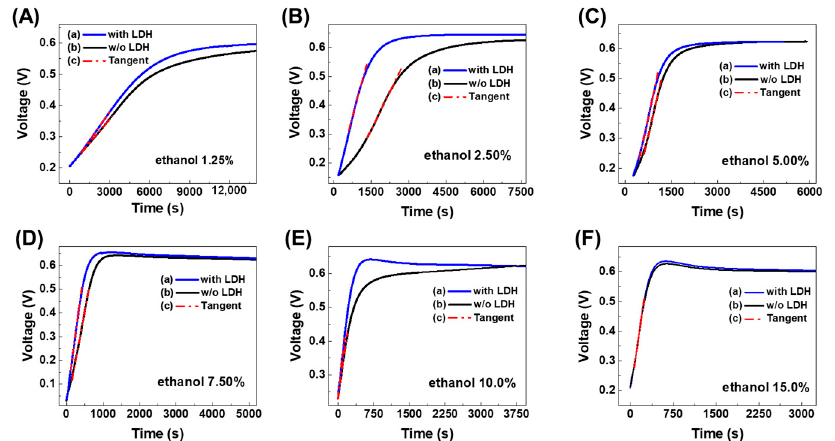
Figure 2. Open-circuit fuel cell voltage charge curves as voltage vs. time, performed by operating with different percentages of hydroalcoholic solution: ( A ) 1.25%, ( B ) 2.50%, ( C ) 5.00%, ( D ) 7.50%, ( E ) 10.0%, and ( F ) 15.0%. Each figure shows the tangent line (c) at the point of maximum slope to the obtained curves: (a) in the presence of LDHs (63 mg), (b) without LDHs.